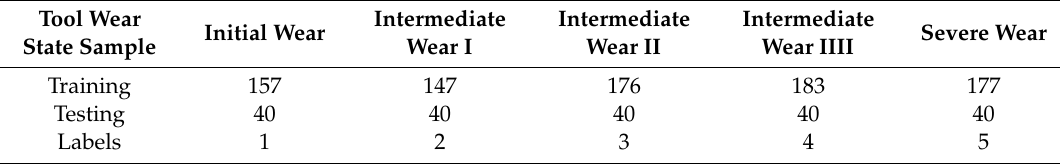
Table 2. Description of the five different tool wear state samples.